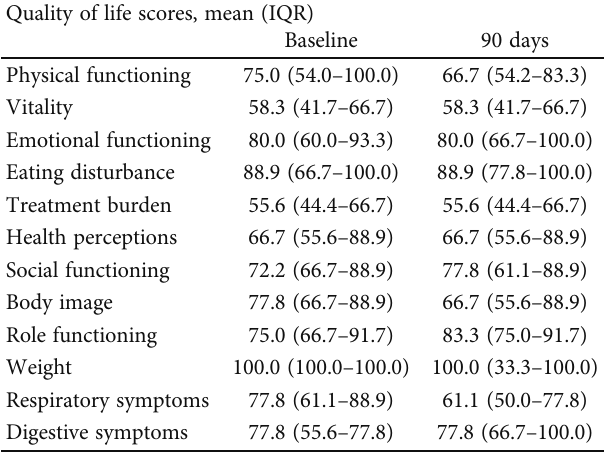
Table 2: Quality of life score measures ( N = 23 ). Quality of life scores, mean